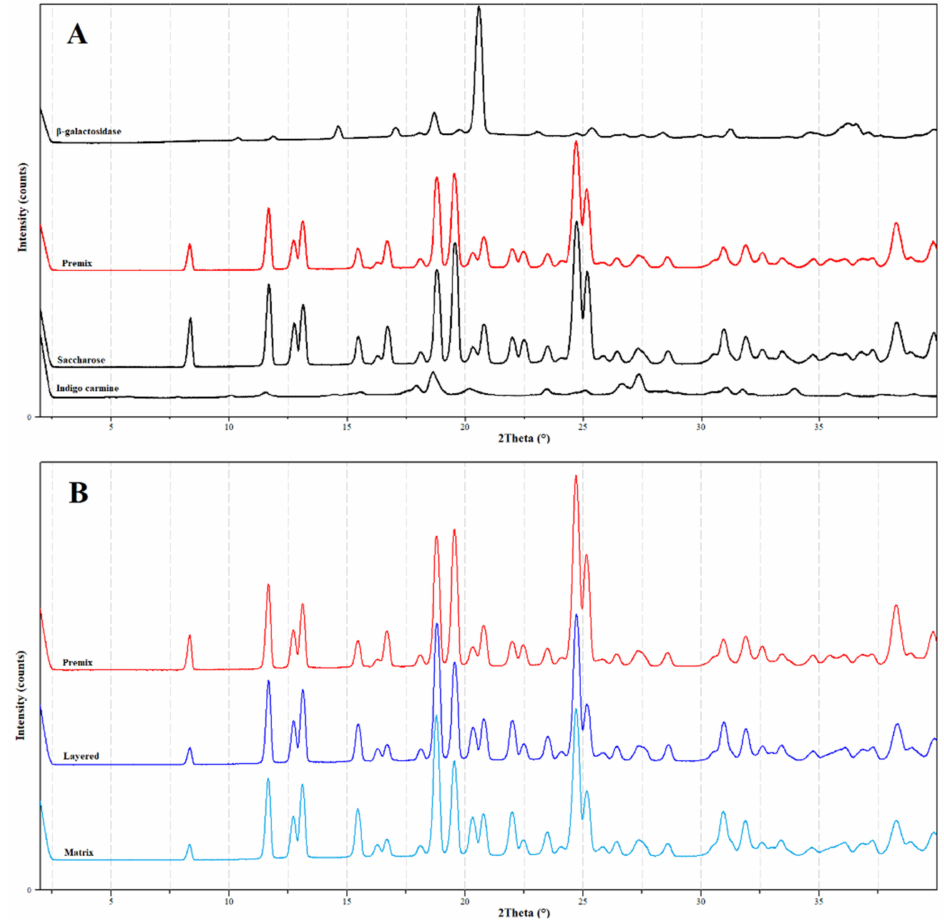
Figure 4. XRD profiles of the used materials ( A ) ( β -galactosidase, saccharose and indigo carmine in black), ( B ) premixed powder (red), powdered layered particles (blue) and powdered matrix particles (light blue).